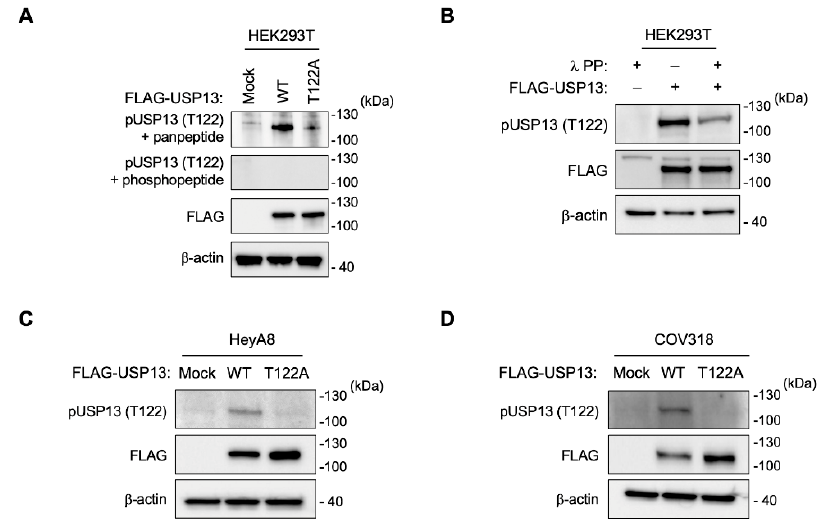
Figure 2. USP13 is phosphorylated at Thr122 in human HEK293T and ovarian cancer cells. ( A ) Anal- ysis of anti-pT122 antibody specificity using peptide competition assay on western blotting (WB) ( B ) WB analysis of HEK293T cells transfected with FLAG-USP13 and preincubated with or without λ -phosphatase as indicated. FLAG-tagged wild-type USP13 (WT) or FLAG-tagged phospho-mutant USP13 (T122A) was transfected into HeyA8 ( C ) and COV318 ( D ) ovarian cancer cells. WB measured the levels of pT122 and FLAG-USP13. β -Actin was used as a loading